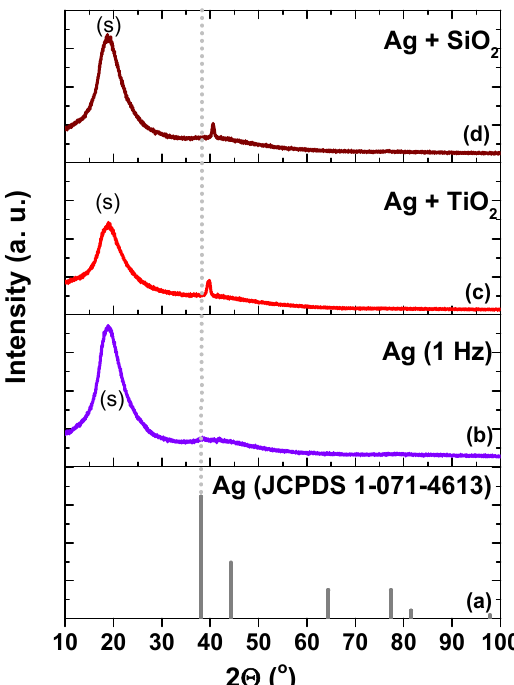
Figure 6. XRD spectra of thin films obtained during 30 min sputtering of Ag at 1 Hz, without any oxide ( b ), with TiO 2 ( c ), and with SiO 2 ( d ), respectively. The position of Ag peaks in the JCPDS card is depicted in ( a